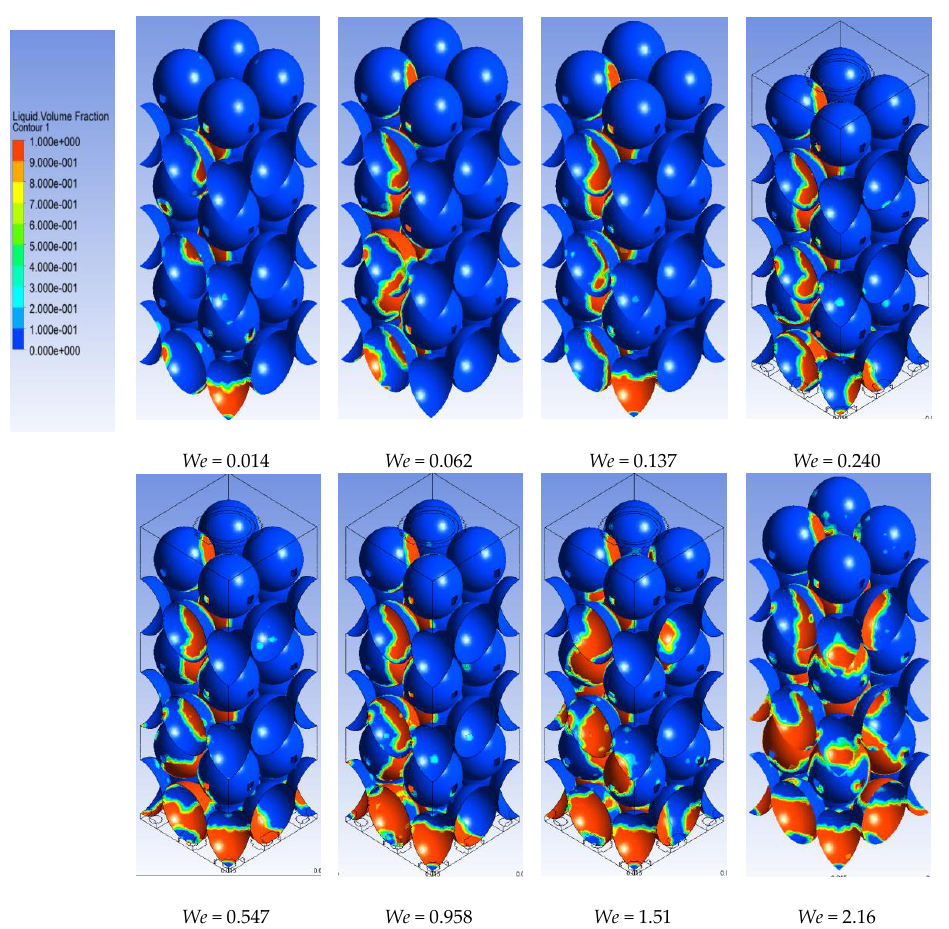
Figure 6. Liquid flow regime and wetted area at different liquid We numbers from 0.014 to 2.16 at fixed Re g = 199.